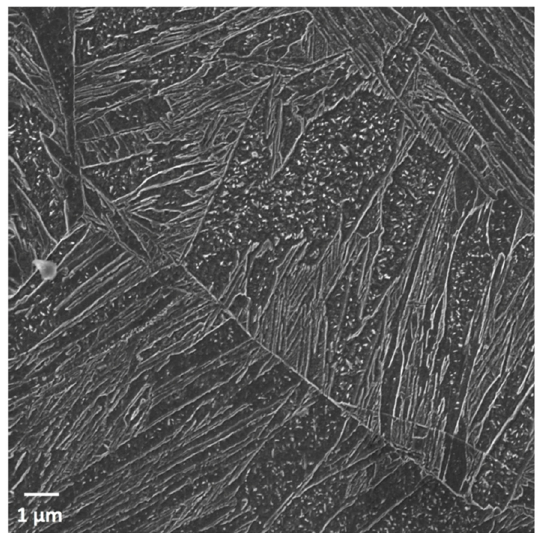
Figure 3. SEM secondary electron micrograph of a quenched sample.